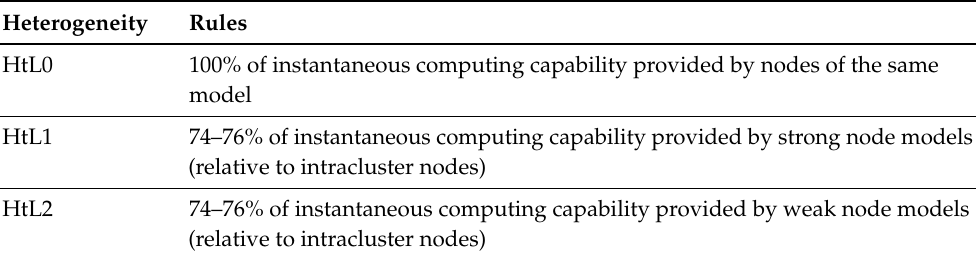
Table 3. Computing-related cluster-level features.